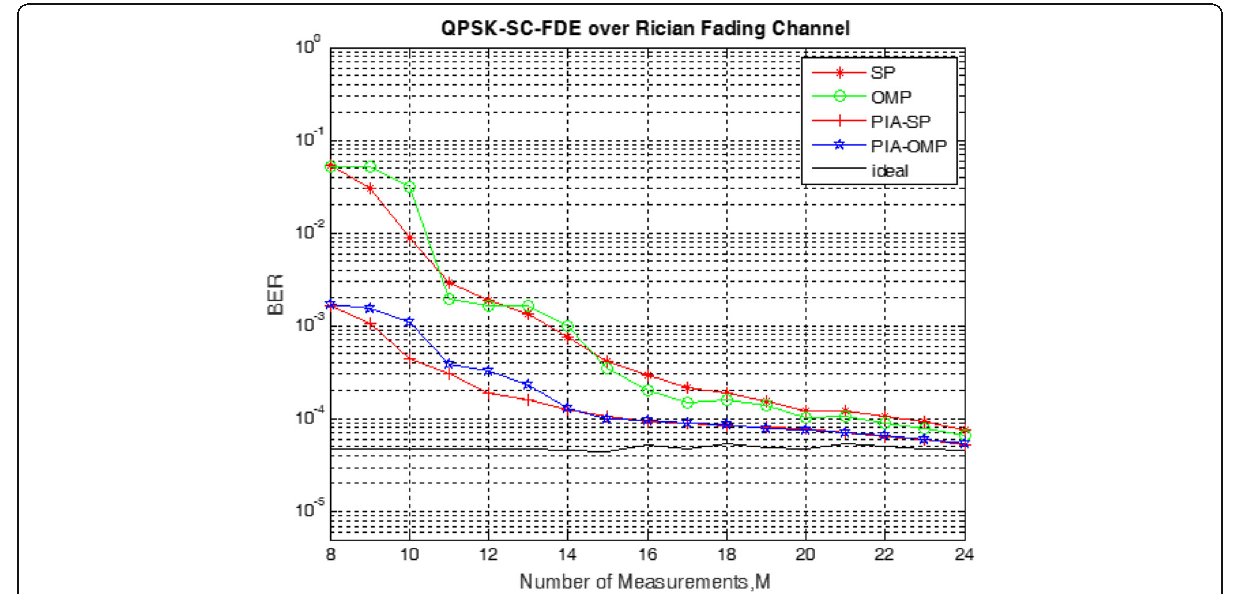
Fig. 7 The BER performance when varying number of measurements is utilized with SNR = 15